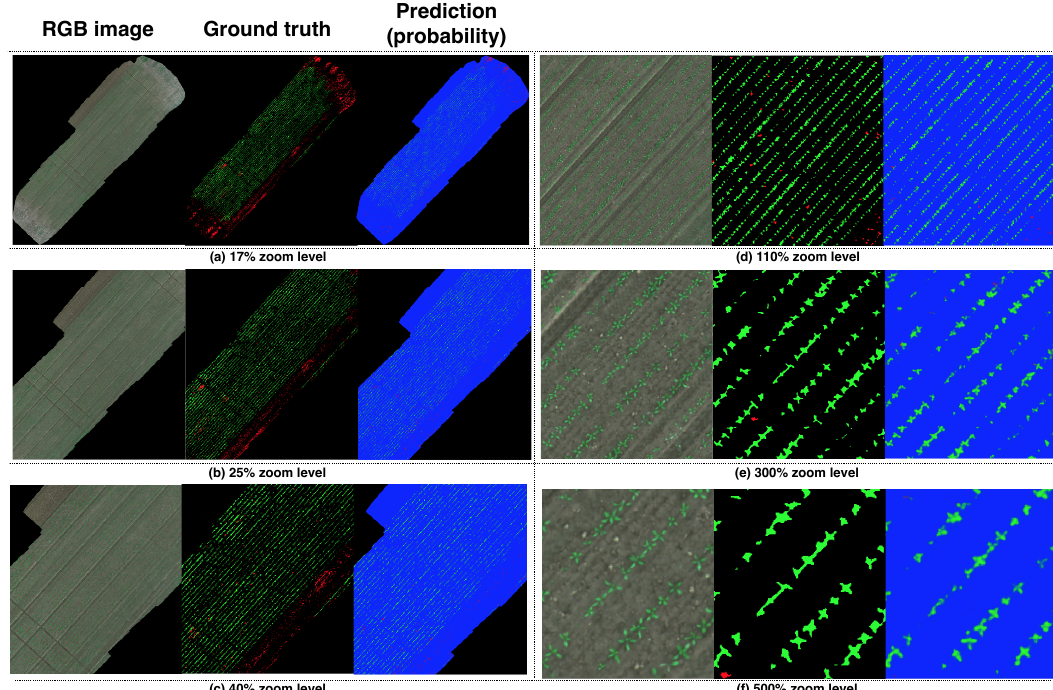
Figure 13. Quantitative results for the RedEdge-M testing dataset (dataset 003). Each column corresponds to an example input image, ground truth, and the output prediction. Each row ( a – f ) shows a different zoom level on the orthomosaic weed map. The color convention follows bg, crop, weed. These images are best viewed in